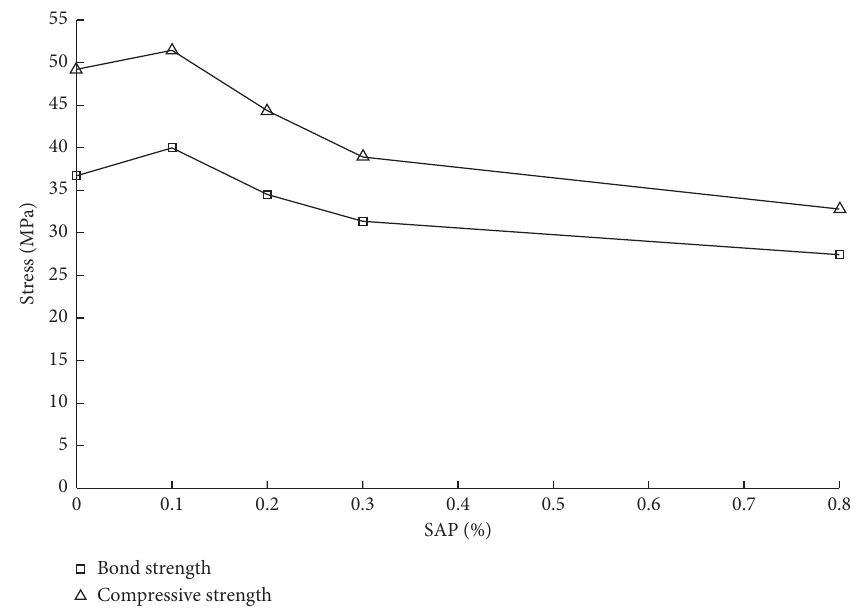
Figure 6: Comparison of bond strength and compressive strength of concrete mixed with SAP. Table 5: Values of A , B , and C in different tests. Table 7. Since the difference between the two is within 5%, equation (9) is suitable for bond strength evaluation.